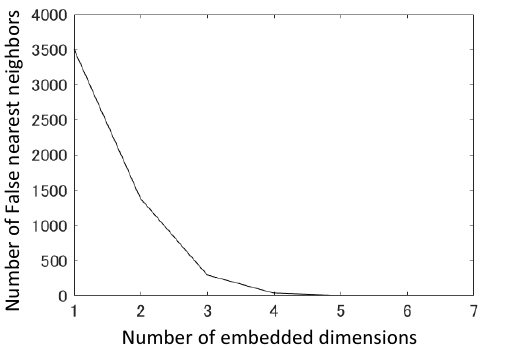
Figure 12. Relationship between k and the number of false nearest